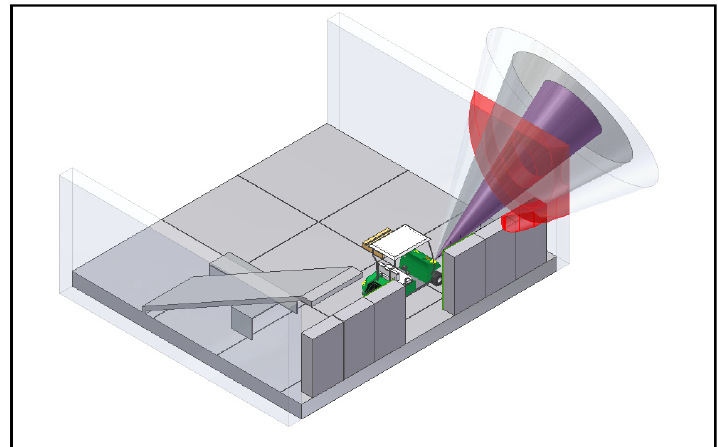
Figure 1. Image of the workstore.